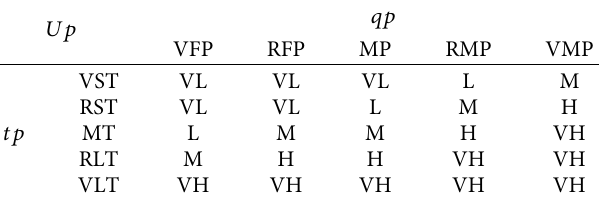
Table 3: Fuzzy rules for the pedestrian urgency judgment module. Up